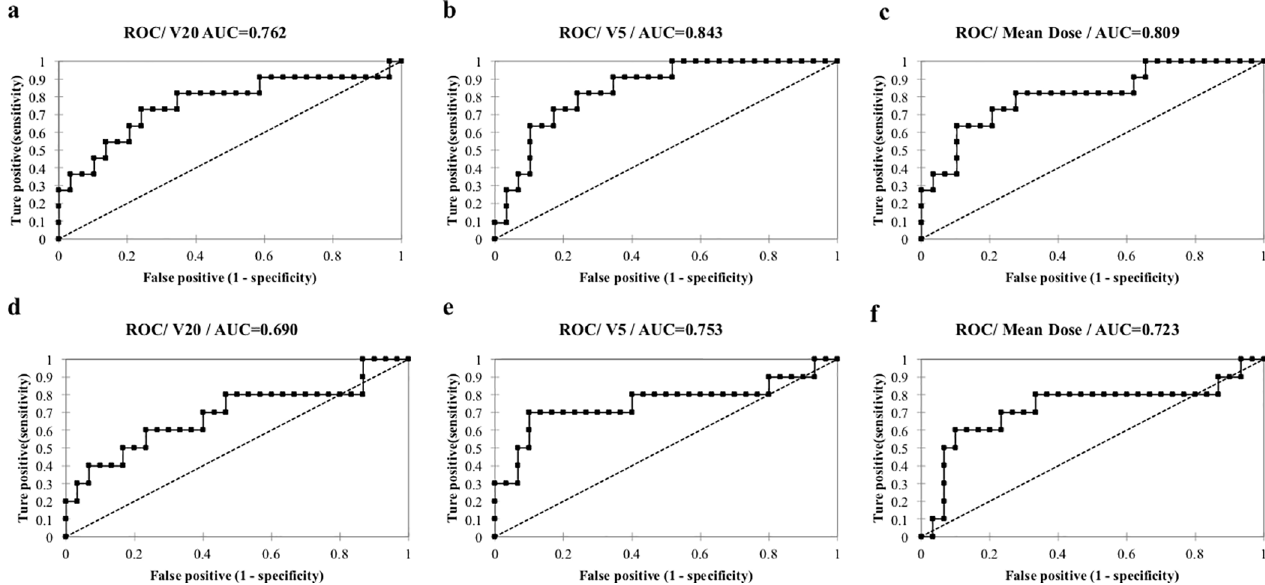
Fig 4. Representative ROCs from 6 cases; for poorly ventilated regions: (a) Mean Dose (b) V5, (c) V20, and for highly ventilated regions: (d) Mean Dose (e) V5, (f) V20.